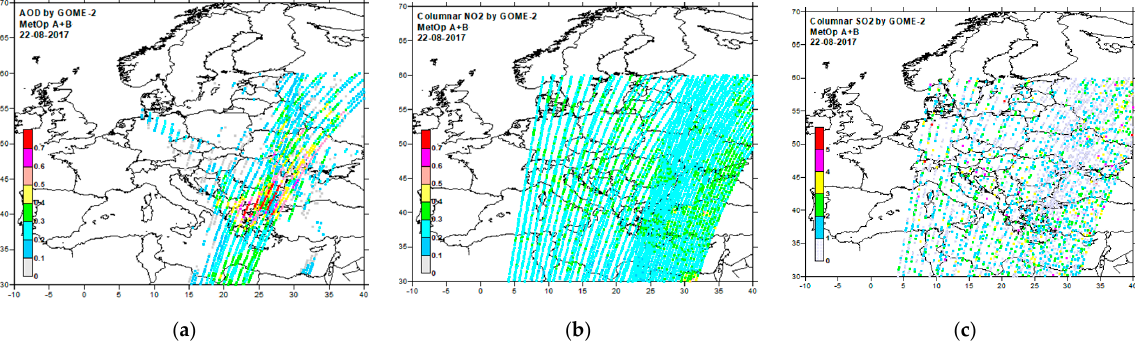
Figure 1. GOME-2 combined MetOp A,B data on 22.08.2017: ( a ) AOD; ( b )VCD_NO 2 ( μ gcm − 2 ); ( c ) VCD_SO 2 ( μ gcm − 2 ), data shown in BgCWFS domain Europe (see Section 2.2).